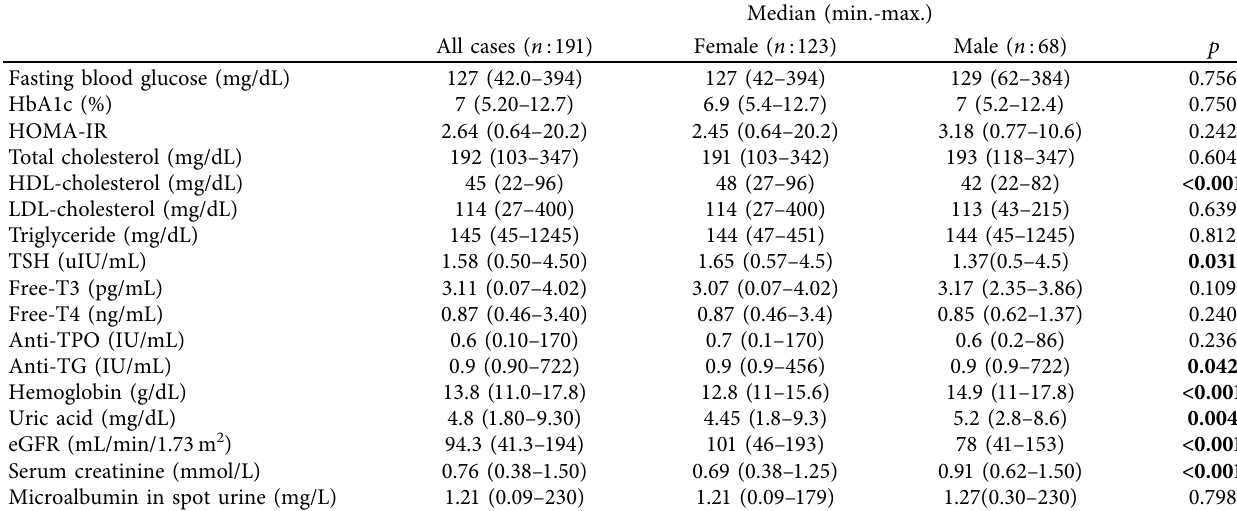
Table 2: Laboratory parameters of all cases with metabolic syndrome (MetS).